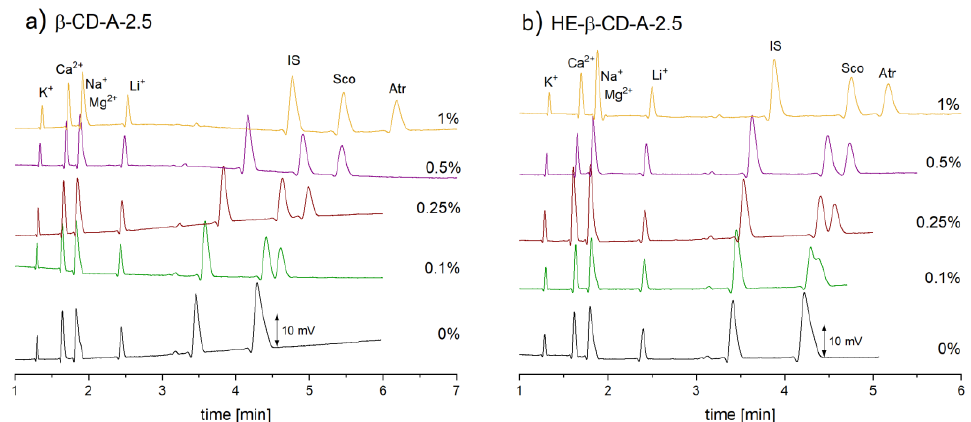
Figure 1. Effect of cyclodextrin concentration ( w/v ) on the separation. BGE: 0.5 M acetic acid with ( a ) β -CD or ( b ) HE- β - CD. Electropherograms for the analysis of standard solution of 25 μg/mL Atr and Sco with 20 μg/mL procaine (IS) and ~ 2 μg/mL inorganic cations (K + , Na + , Ca 2+ , Mg 2+ , Li + ). CE conditions: capillary length 29.9 cm (18.4 cm to the detector); applied voltage: + 11 kV; hydrodynamic injection (siphoning) 7 cm height for 30